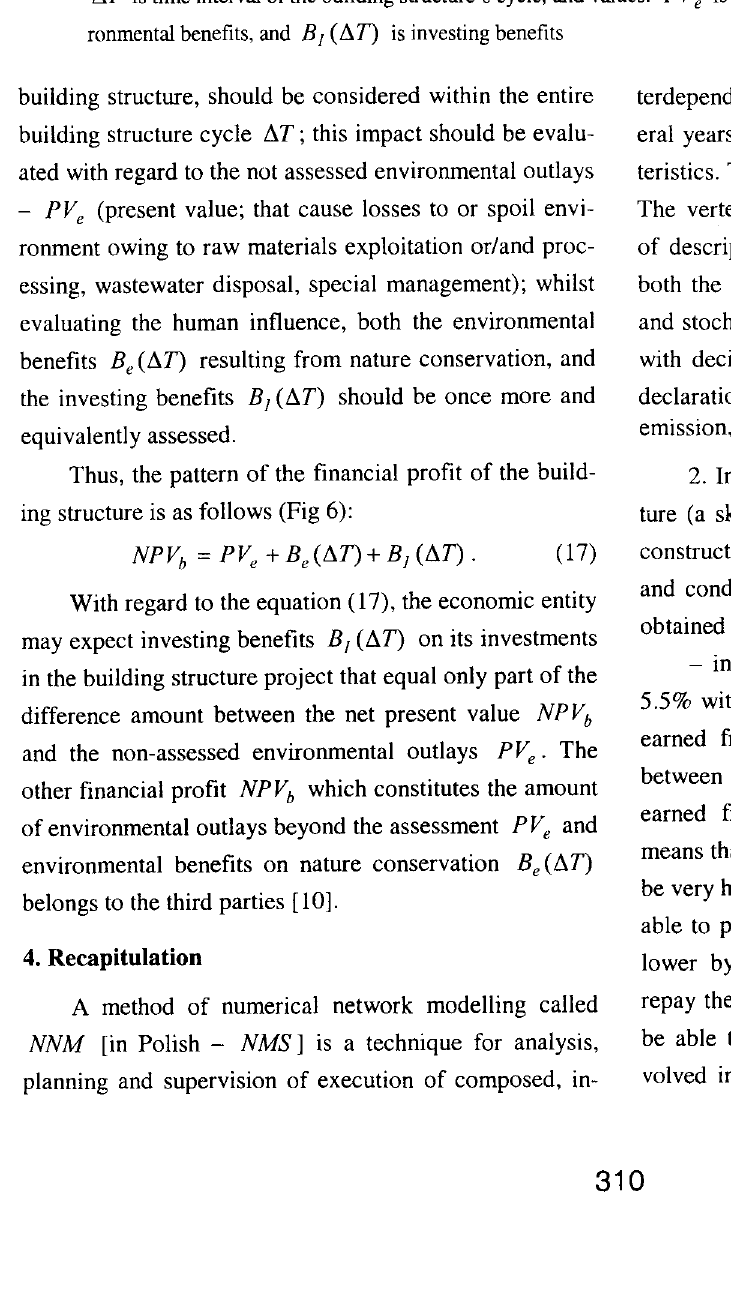
Fig 6. Updated net present values NPVb up to the t -th moment during the project investing period (investing in the sky scraper) where a, b , c -corresponding to the real interest rates 5.5%, 5.5%, and 9.5%, d refers to general renovation work, ~T is time interval of the building structure's cycle, and values: P Ve is non-assessed environmental outlays, Be ( ~T) is